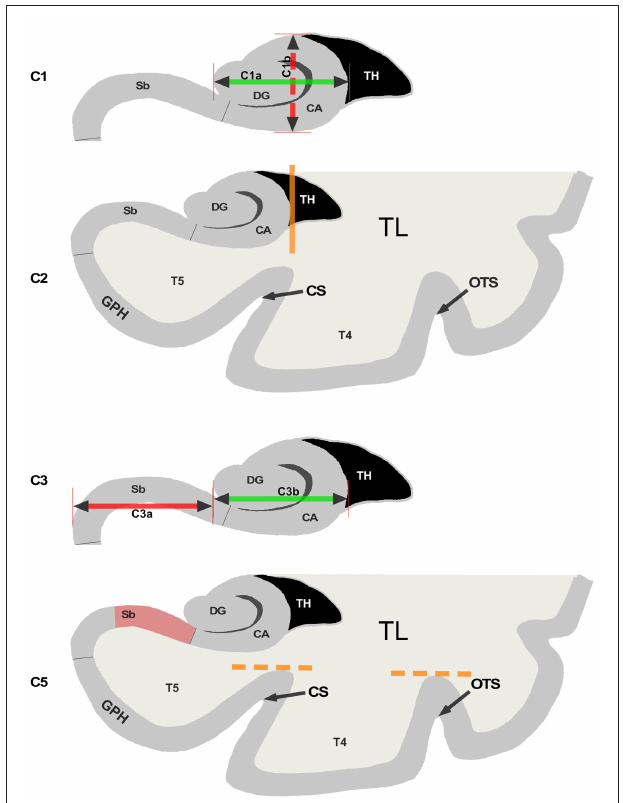
FIGURE 1 | Illustration of the 5 criteria used for the evaluation of Incomplete Hippocampal Inversions. C1: Roundness and verticality. The horizontal arrow (C1a) goes from the medial part of the Dentate Gyrus (DG) to the lateral part of the hippocampus. The vertical arrow (C1b) goes from the bottom to the top part of the Cornus Ammonis (CA) C2: Verticality and depth of the collateral sulcus. The vertical line indicates the lateral border of the hippocampus which is used to determine if the sulcus is deep or not. CS indicates the collateral sulcus and OTS the occipito temporal sulcus. C3: Medial positioning. The C3a segment indicates the part of the subiculum (Sb) not covered by the DG. The C3b segment indicates the part of CA covered by the DG. C5: Orientation of the sulci of the fusiform gyrus. The dotted lines indicate the top of the sulci CS and OTS. The upper part of the subiculum is the red